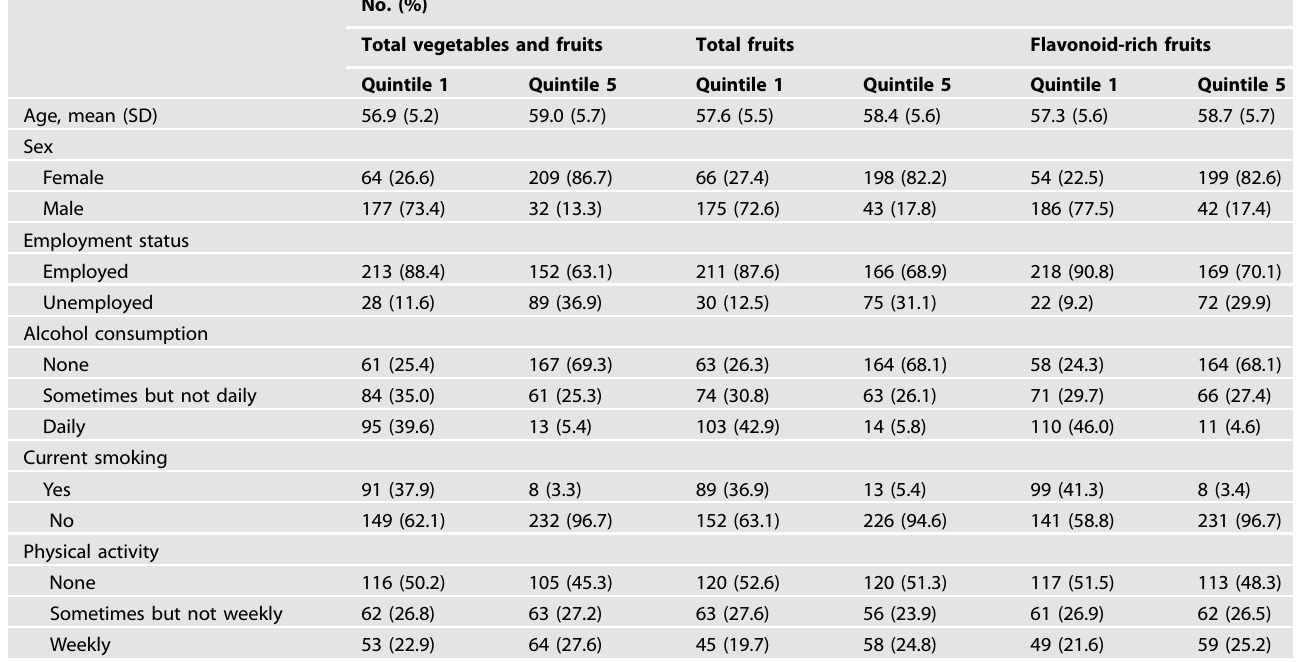
Table 1. Demographics of participants in 1995 according to lowest and highest quintiles of total vegetable and fruit, total fruit, and fl avonoid-rich fruit